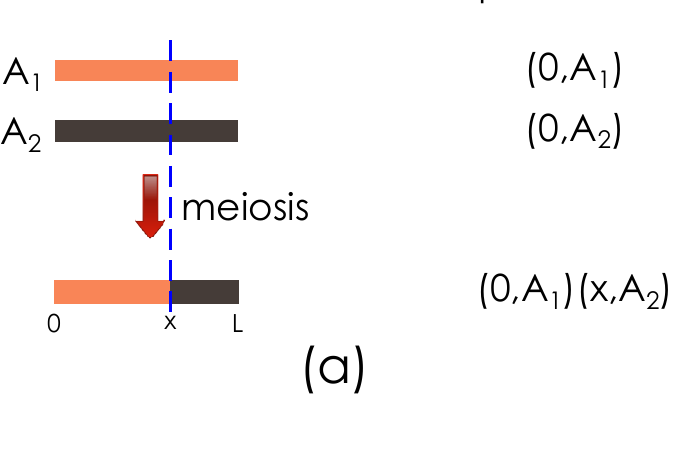
Figure 2. Illustration of the genome segment representation. ( a ) Representation of founder genome A haploids, A , A , and the result of meiosis with a crossover at x are shown; 1 2 ( b ) Output from (a) and founder haploid B are shown going through meiosis, with a new crossover introduced at y